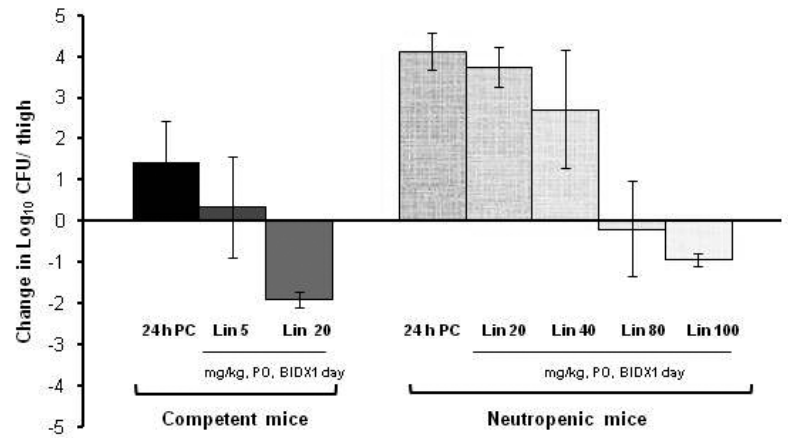
Figure 1. Comparison of linezolid efficacy in immunocompetent mice at 5 and 20 mg/kg dose) and in immunocompromised mice at 20, 40, 80 and 100 mg/kg BW dose) in thigh infection model of S. aureus 25923.